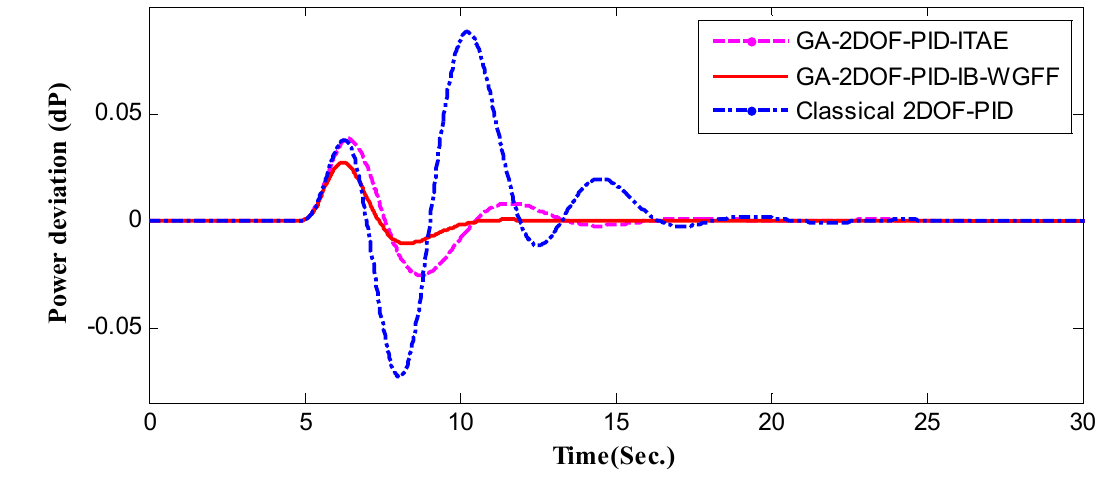
Figure 19. Δf (cid:2870) , using GA implementing ITAE, IB-WGFF and classical 2DOF-PID.